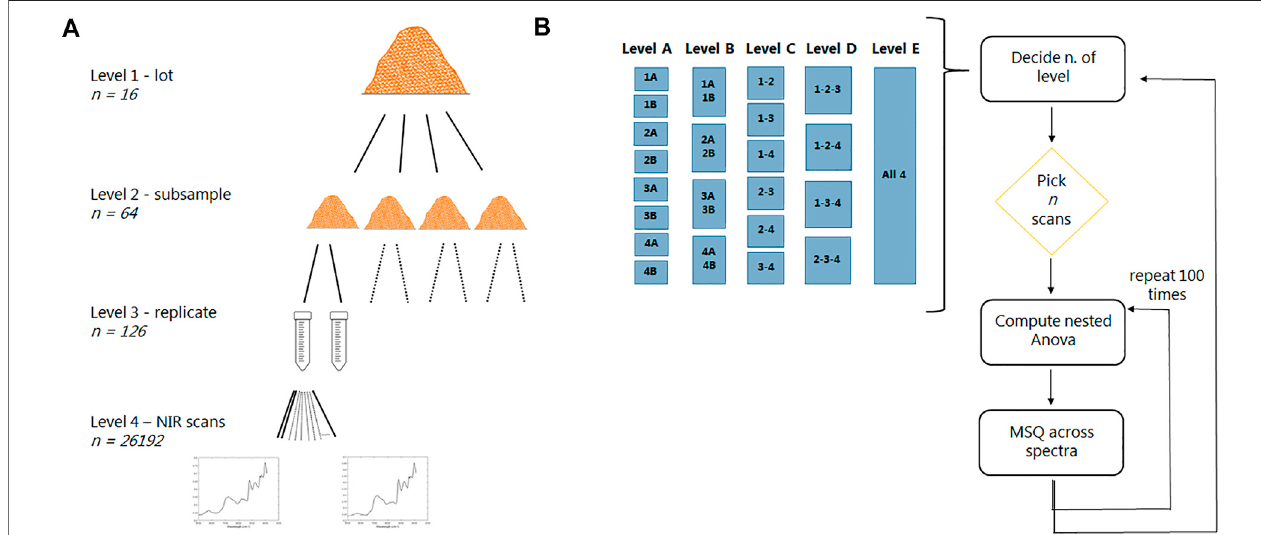
FIGURE 1 | A) Schematic representation of the hierarchical sampling procedure. Please note that there “ only ” are 126 samples at level 3 due to some unfortunate problemsduringtheNIRanalysis. (B) Schematicrepresentationofthedataanalysisprocedure( n isthenumberofrandomscansselected).LevelA,eachsubsampleand replicate are represented equally; level B, each subsample is represented equally; level C, groups of two subsamples are represented equally; level D, groups of three subsamples are represented equally; level E scans are selected freely among all subsamples and replicates.